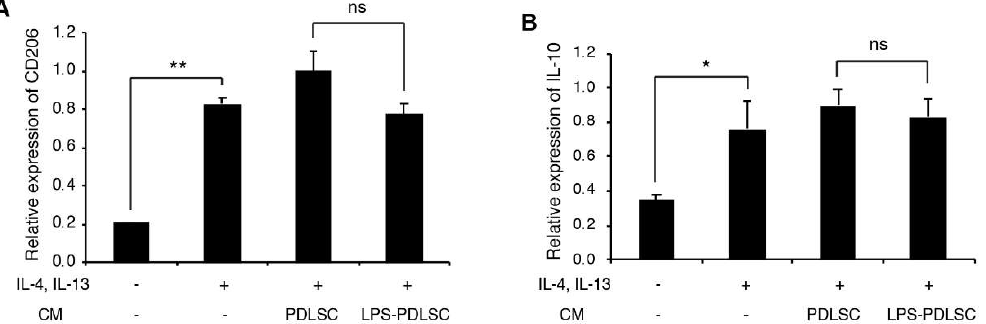
Figure 4. Effect of PDLSCs or LPS-preconditioned PDLSCs on the polarization of THP-1 cells with M2 stimulating agents. The conditioned media from PDLSCs or LPS-preconditioned PDLSCs were added to M0 THP-1 cells with 20 ng/mL of IL-4 and IL-13. Relative mRNA expression of CD206 ( A ) and IL-10 ( B ) were analyzed by RT-qPCR. CM: the conditioned medium from PDLSC and LPS-PDLSC: The conditioned media from LPS-preconditioned PDLSCs. Data shown as the mean ± SD, n = 3, ns: Not significant, * p < 0.05, ** p < 0.01.